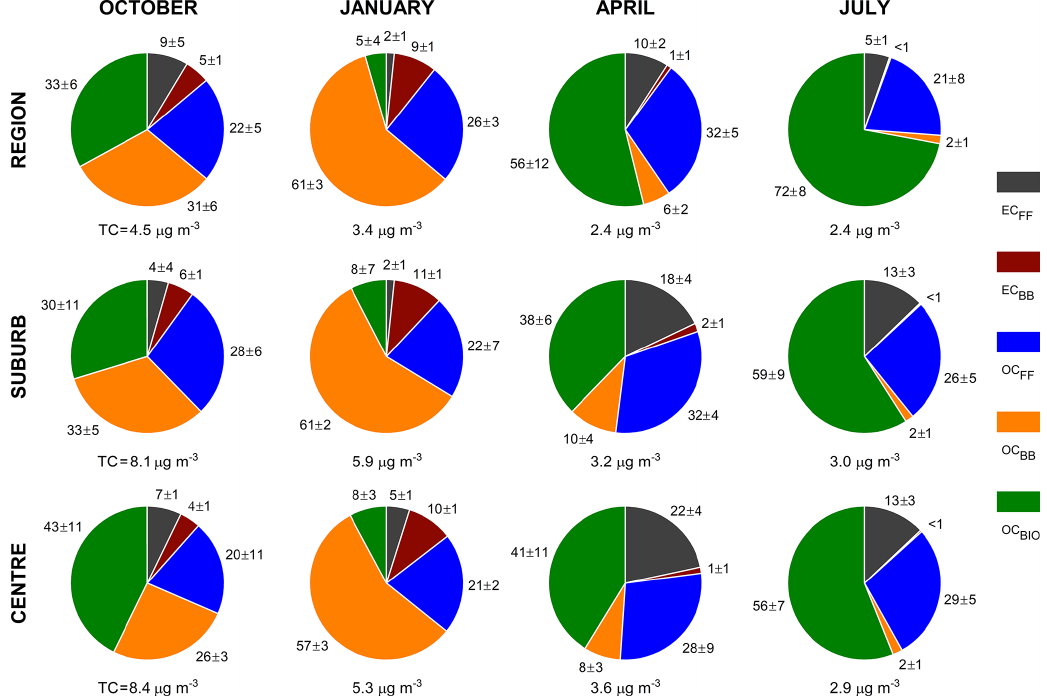
Figure 5. Mean contributions with SDs of elemental carbon from fossil fuel combustion (EC FF ) and from biomass burning (EC BB ), of organic carbon from fossil fuel combustion (OC FF ), from biomass burning (OC BB ) and from biogenic sources (OC BIO ) to PM 2 . 5 -fraction total carbon (TC) in percentage for regional background in the Carpathian Basin, suburban area and city centre of Budapest and for different months representing different seasons. The median atmospheric concentrations of TC are indicated under individual circle charts, while the corresponding mean TC / PM 2 . 5 mass ratios are shown in Table